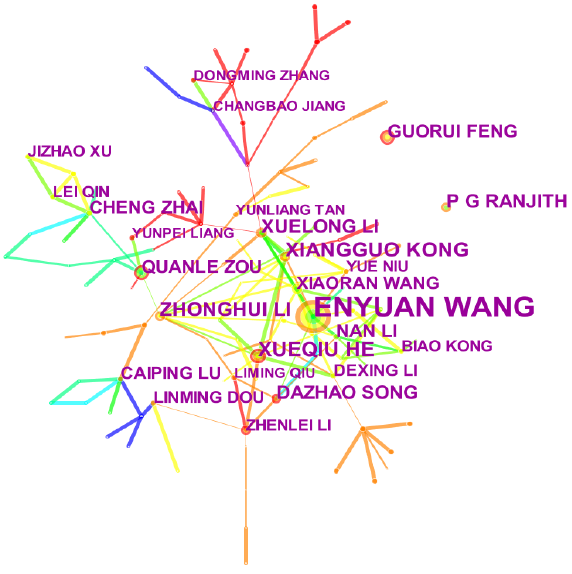
Figure 8. Author cooperation network.